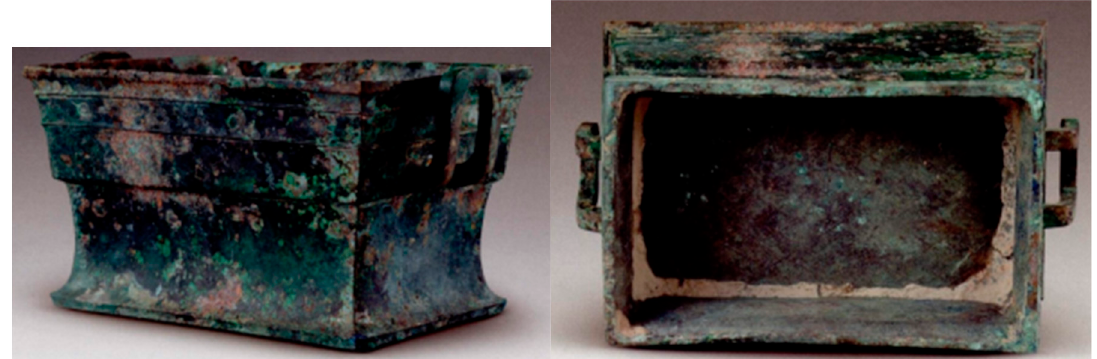
Wang provides other obvious evidence that the yi graph B 釴 = 翼 / 異 does not refer to a gui